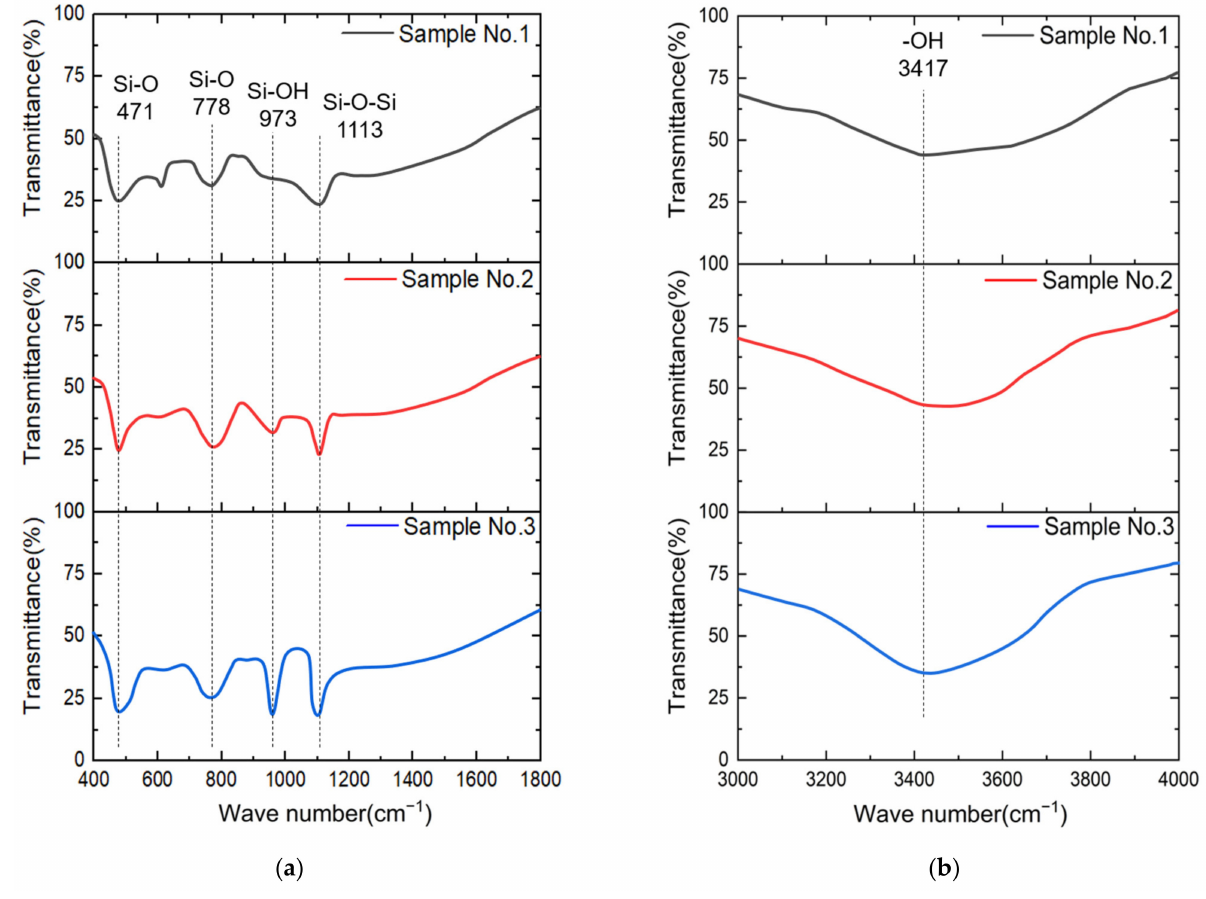
Figure 9. FTIR spectra of different samples: ( a ) 400–1800 cm − 1 ; ( b ) 3000–4000 cm − 1 .